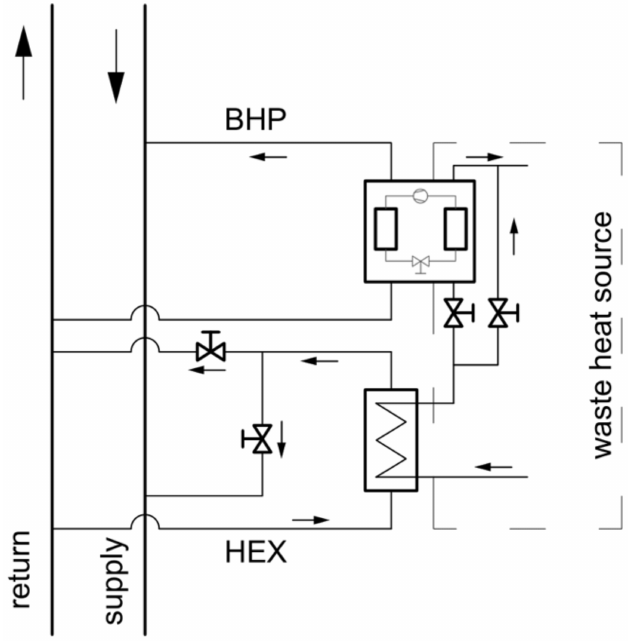
Figure 6. Heat utilization scheme: Heat exchanger (HEX) and booster heat pump